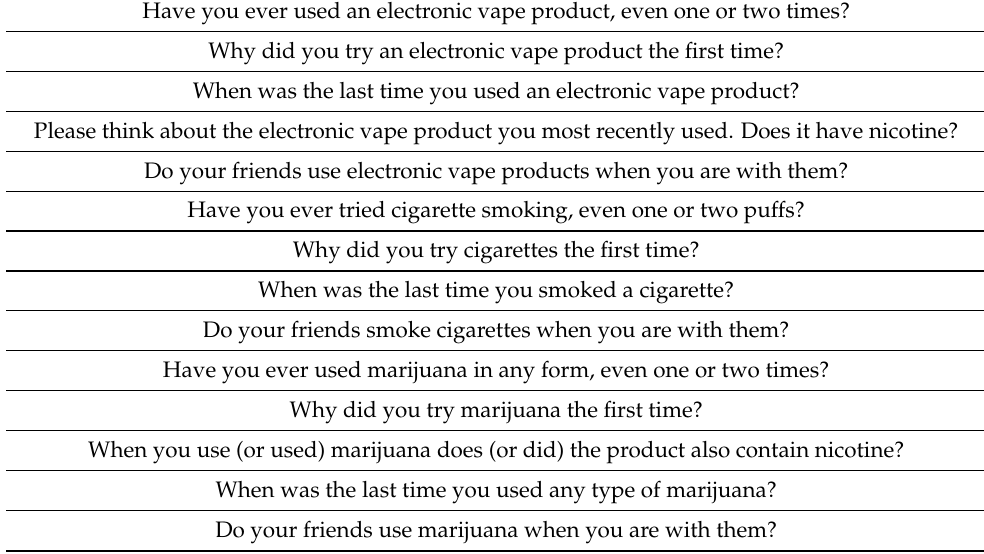
Table 1. Questions asked of